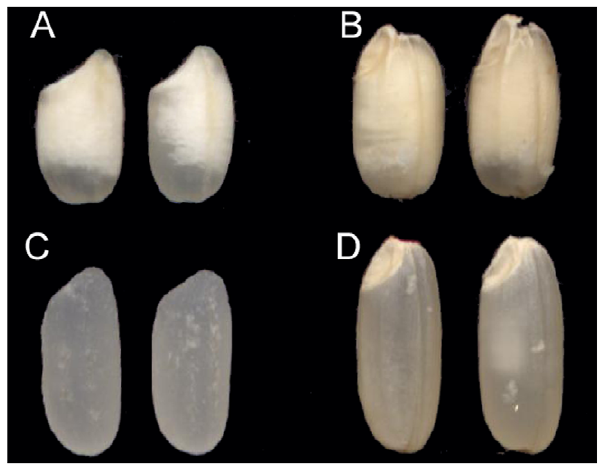
Figure 1. Comparison of grain chalkiness and transparency between Jiangtangdao 1 and Miyang 23. A, Milled rice of Jiangtangdao 1. B, Brown rice of Jiangtangdao 1. C, Milled rice of Miyang 23. D, Brown rice of Miyang